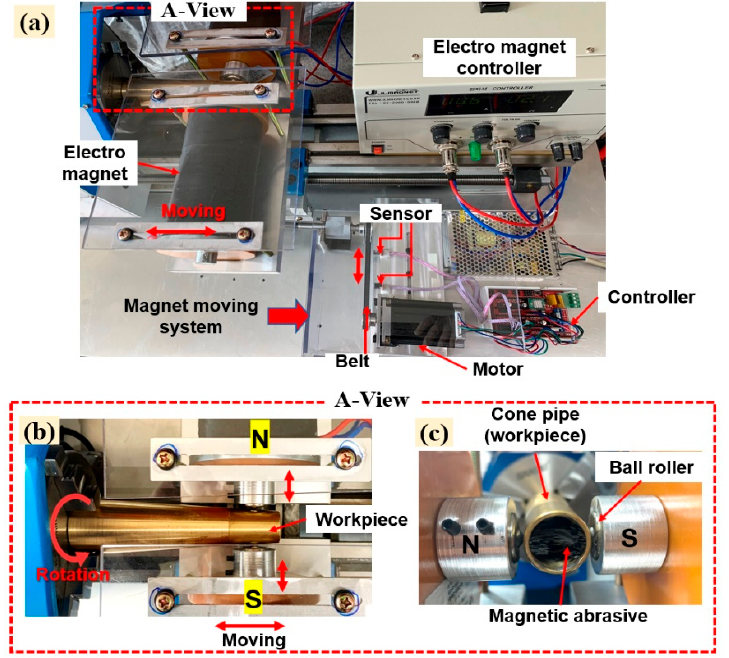
Figure 2. Photo view of a magnetic abrasive finishing process using moving electromagnets for the deformed pipe: ( a ) full view, ( b ) top view, and ( c ) front view.